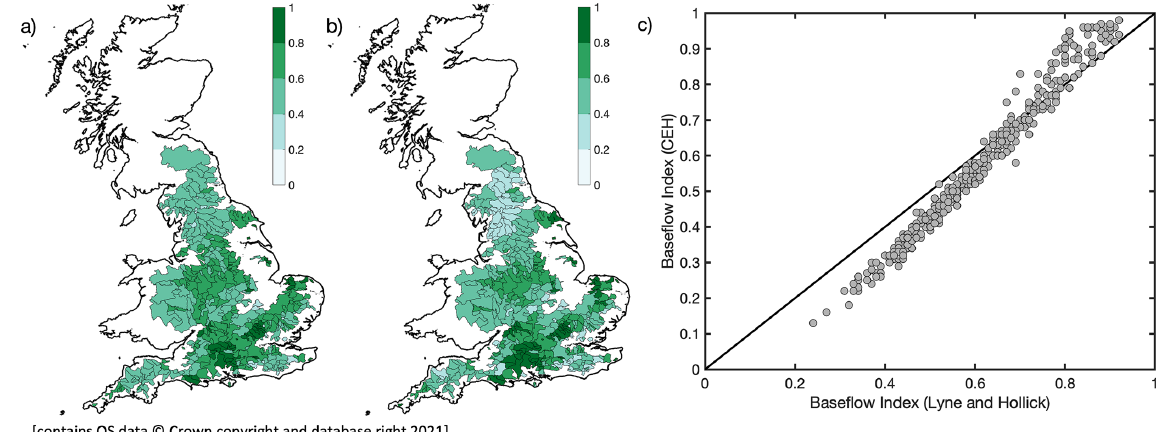
Figure 3. The distribution of (a) BFI_CEH and (b) BFI_LH and (c) the relationship between the two measures of BFI with a 1 : 1 line for